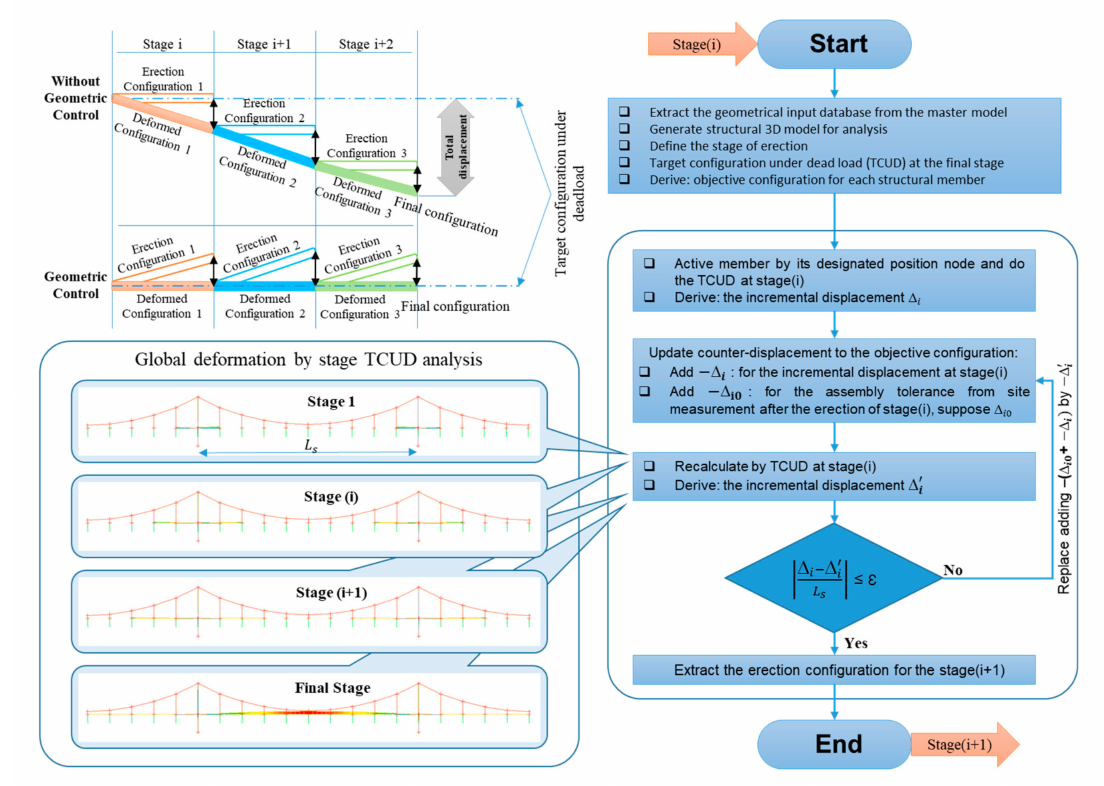
Figure 14. Geometric control during the assembly